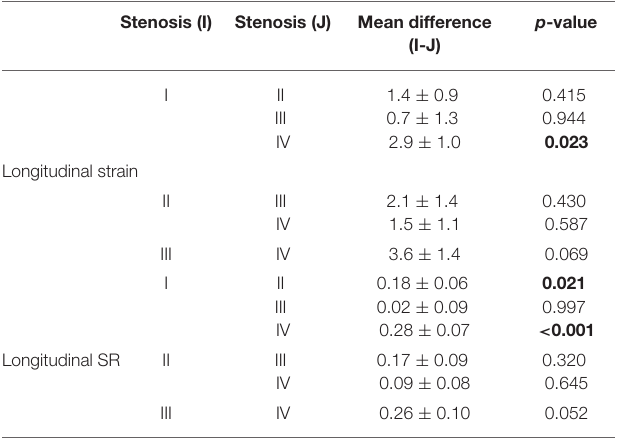
TABLE 3 | Longitudinal strain and SR according to coronary artery stenosis